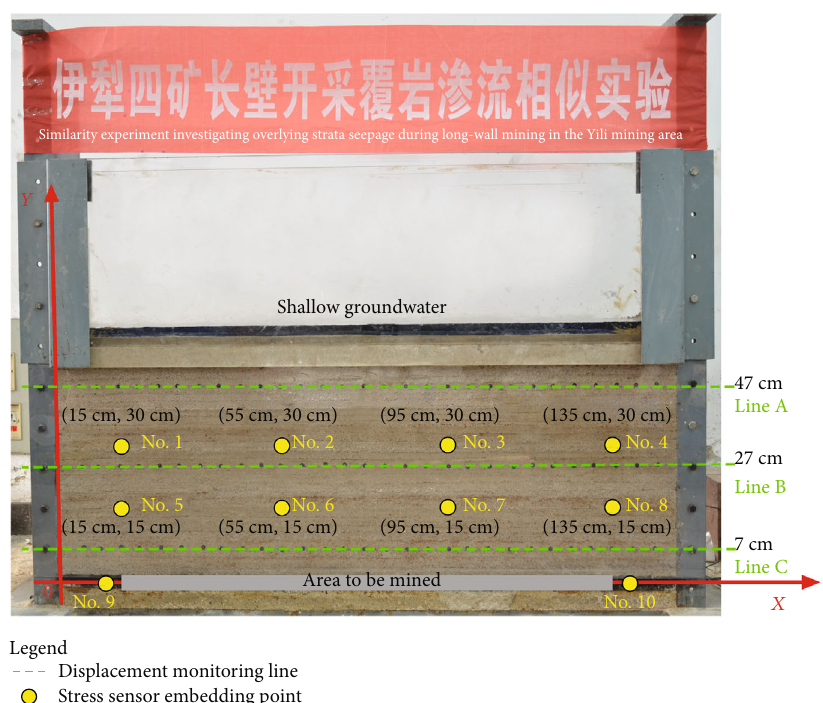
Figure 5: Distribution of stress and displacement monitoring